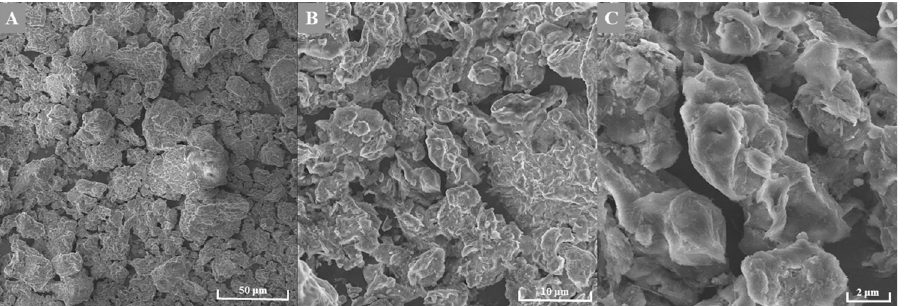
Fig 1. Structure of purified and activated bentonite at different magnifications (SEM). A) 1.00 kx, B) 5.00 kx and C) 15.0 kx.